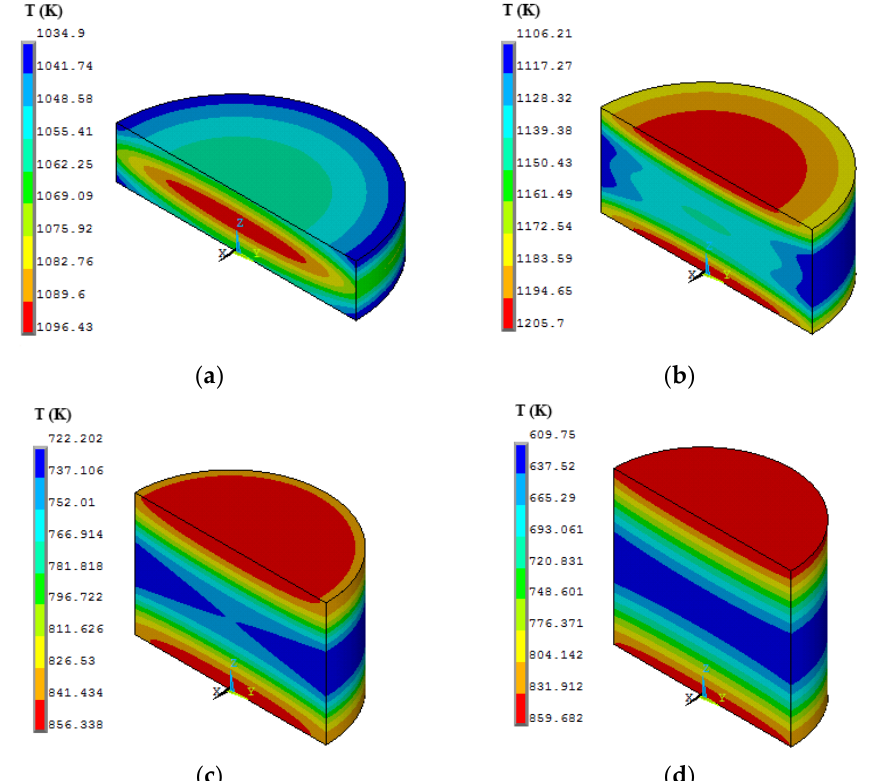
Figure 3. Temperature distribution inside the cylindrical ilmenite after being heated for 4 min with the variation of cylinder height: ( a ) L =0.015 m; ( b ) L = 0.03 m; ( c ) L = 0.045 m; ( d ) L = 0.06 m.